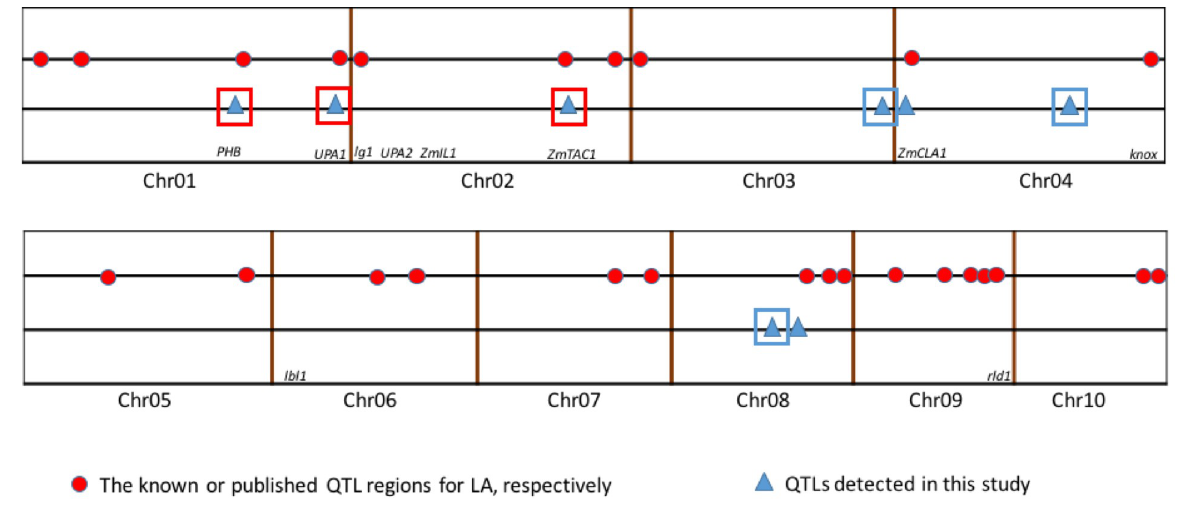
Fig 3. Comparison of QTL mapping results in this study with the results reported by previous